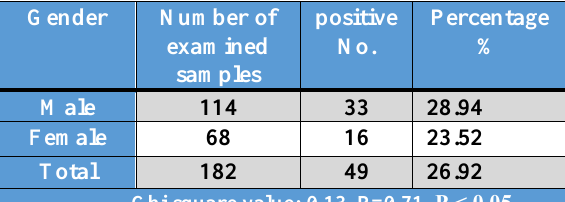
Table, 4: Total infection rate of Giardia lamblia according to gender in asymptomatic patients Gender Number of examined samples